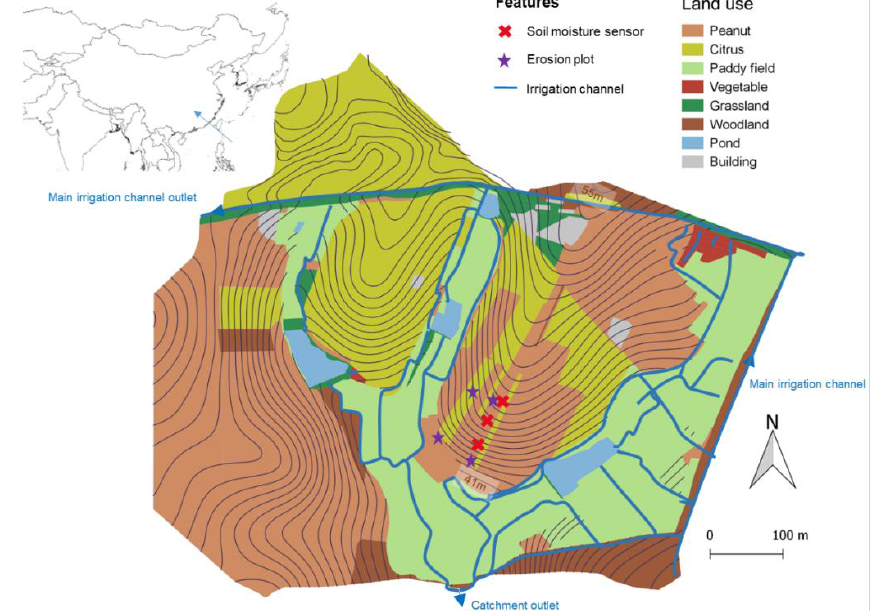
Figure 1. Map of the Sunjia catchment and its land uses; the altitude lines are in 1 m increments.